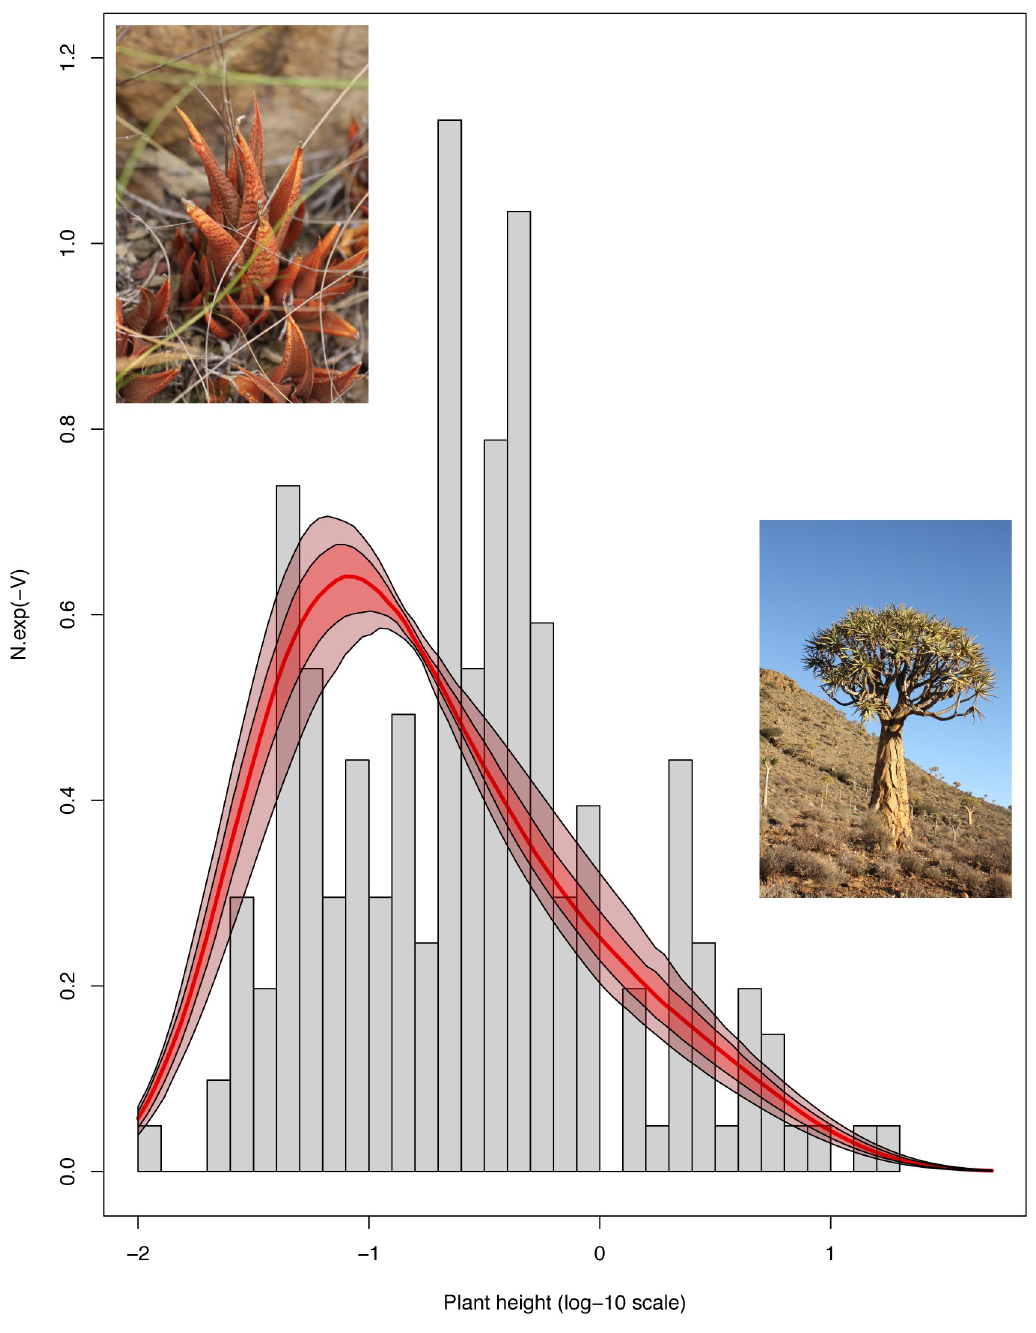
Fig 1. Current distribution and evolution of maximum vegetative height across Alooideae. The observed distribution of height across current Alooideae is shown as a histogram. Macroevolutionary landscapes estimated under the BBMV4 model over the phylogenetic posterior have been superimposed: the solid line shows the median landscape estimated over the 100 posterior trees. Polygons around the median of the phylogenetic posterior show the 50% (dark red) and 90% (light red) quantiles of macroevolutionary landscapes. Inset pictures show representatives of the shortest and tallest genera of Alooideae: Haworthiopsis venosa (10 cm) on the left, and Aloidendron dichotomum (6 m) on the right. Both pictures by F. C. Boucher.